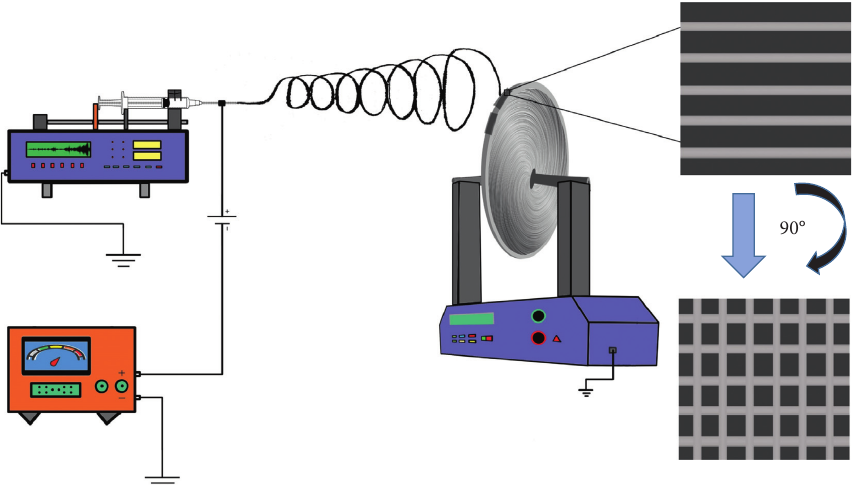
Figure 1: Schematic drawing of the electrospinning setup with a rotating disc